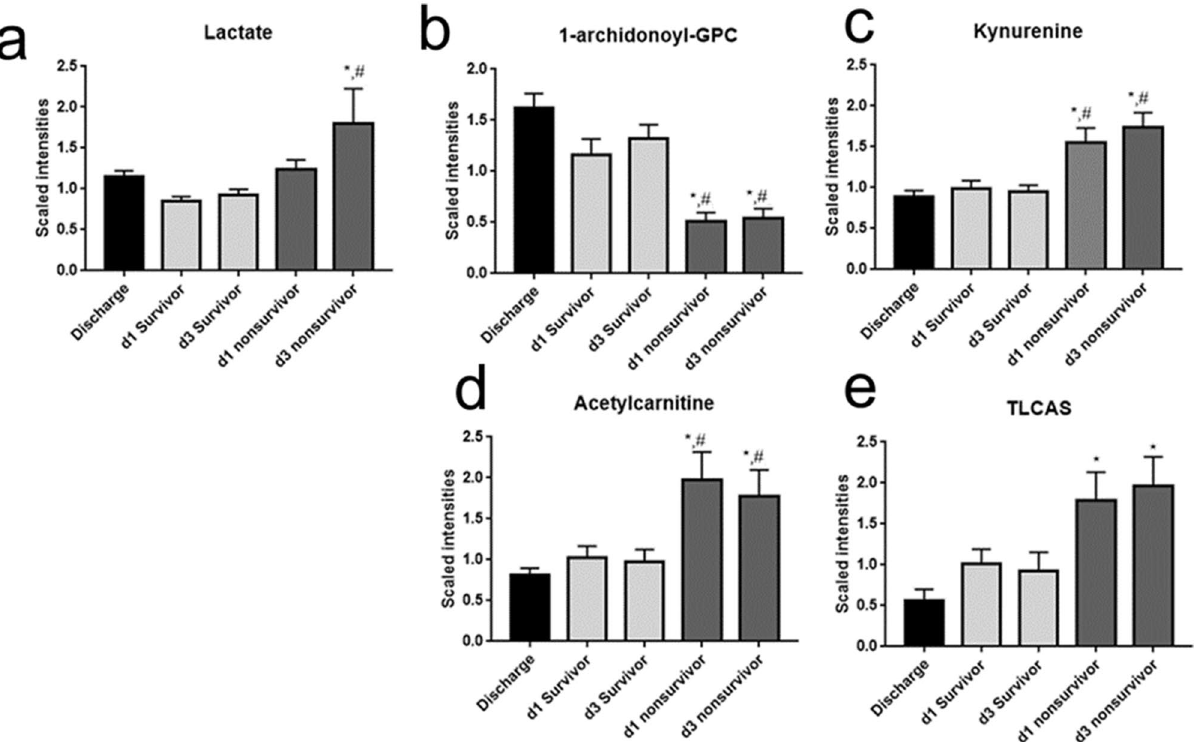
Figure 3. Demographics and semiquantitative analysis of sepsis outcomes predictive metabolite. ( A – F ) semiquantitative analysis of outcome predictive metabolites. Significant difference using ANOVA and 5% FDR. *, significantly different from discharge; #, significantly different from time-matched survivor. Figures made utilizing GraphPad Prism 7.0. https:// www. graph pad. com/ scien tific- softw are/